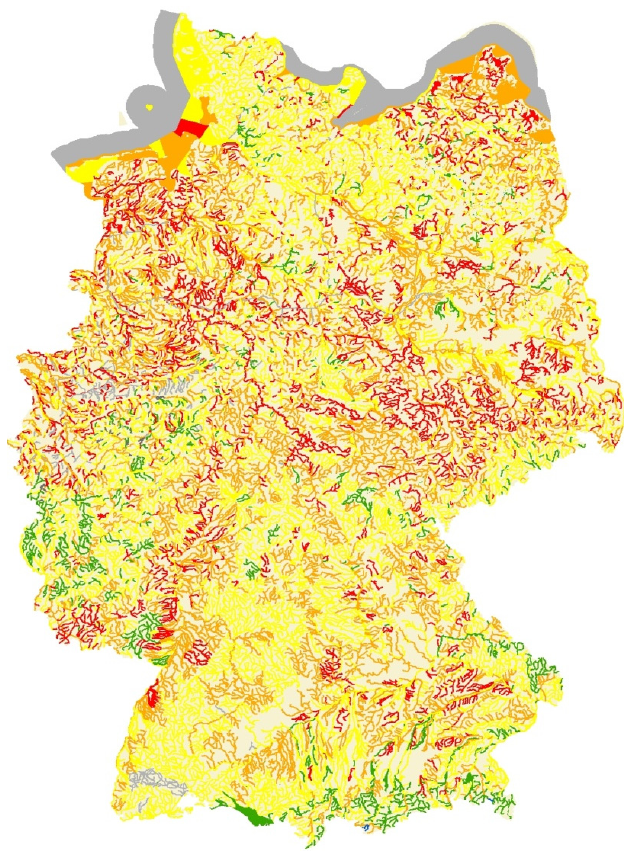
Figure 5. Ecological status/ecological potential of surface water bodies in Germany. Blue color = very good status; Green color = good status/potential; Yellow color = moderate status/potential; Orange color = poor status/potential; Red color = bad status/potential; Grey color = status/potential unknown. Source: Federal Environment Agency after data from the German reporting portal WasserBLIcK/BfG 2015.